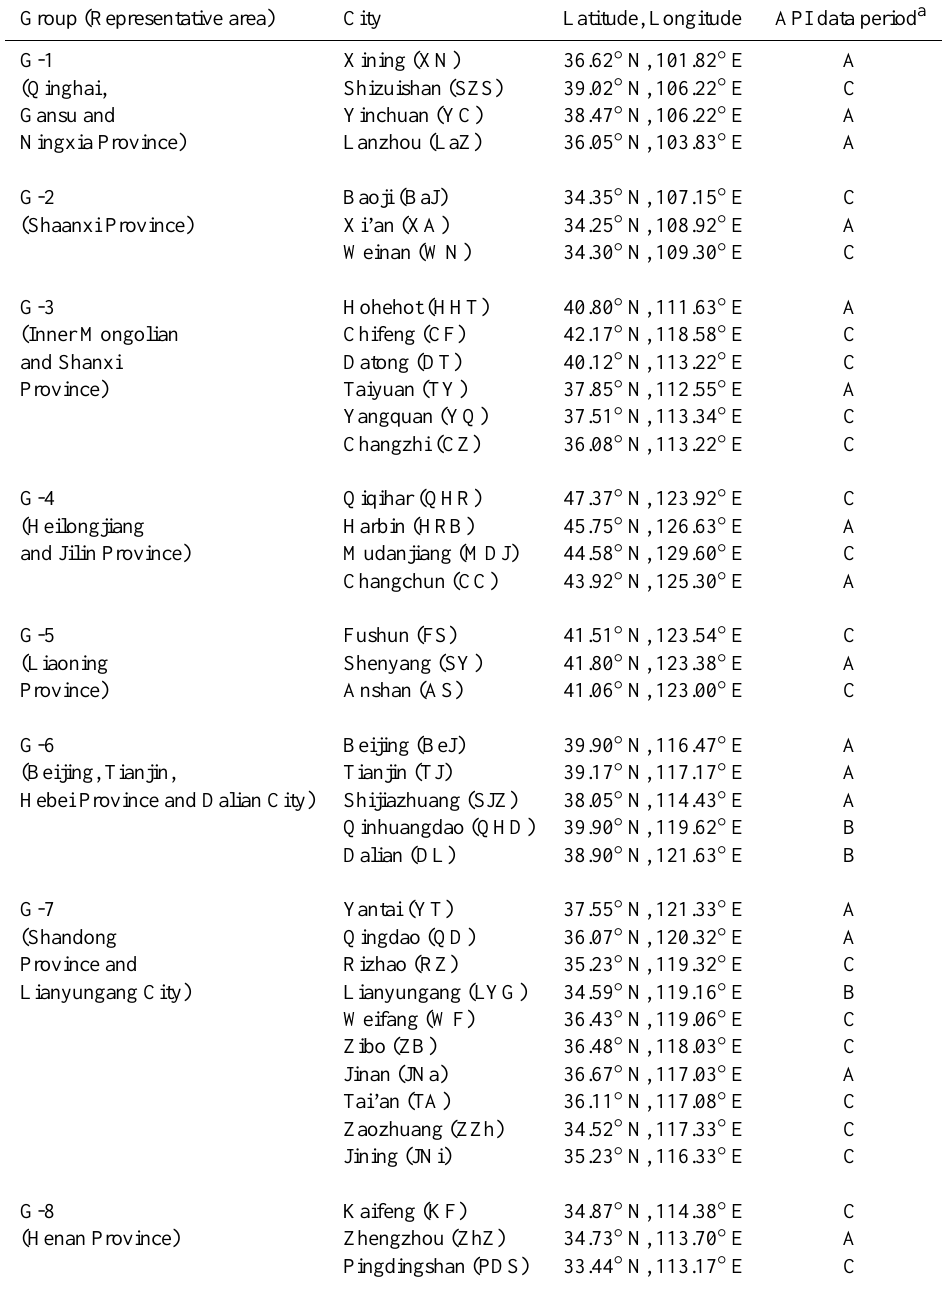
Table 1. Locations, groups and air pollution index (API) data available period of the eighty-six cities in China. Group (Representative